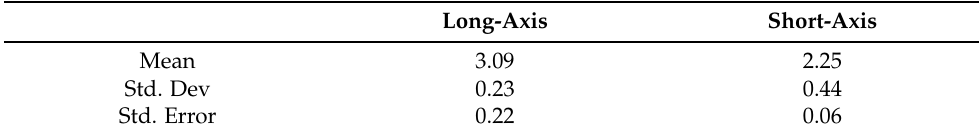
Table A2. Mean biopsies dimensions for healthy tissue ( n = 4).